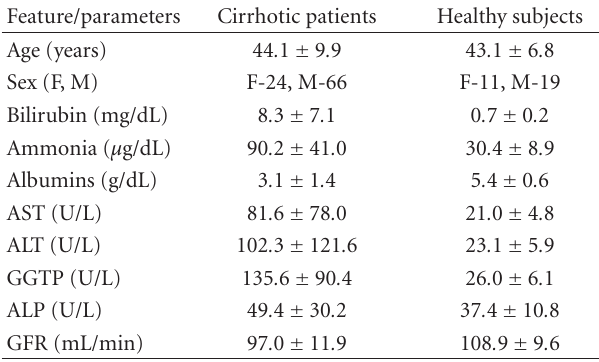
Table 1: Characteristics of the subjects enrolled in the study (mean values ±